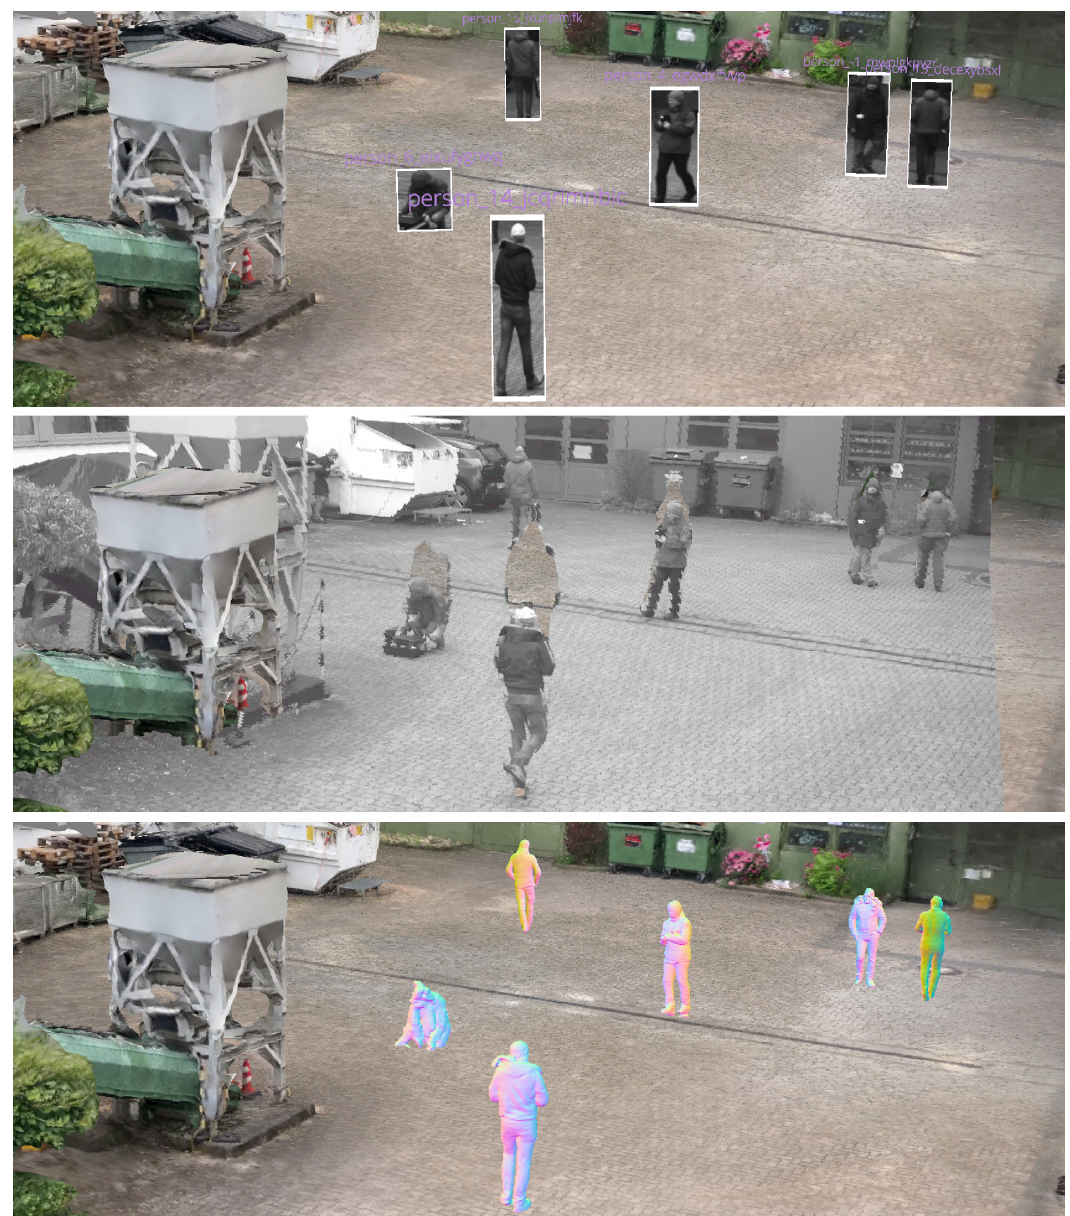
Figure 5. Dynamic objects can be displayed differently in the static 3D reconstruction. ( Top ) Detected bounding boxes of persons are embedded upright. ( Center ) Complete depth map of the segmented image is superimposed. ( Bottom ) People reconstructed with PIFuHD are